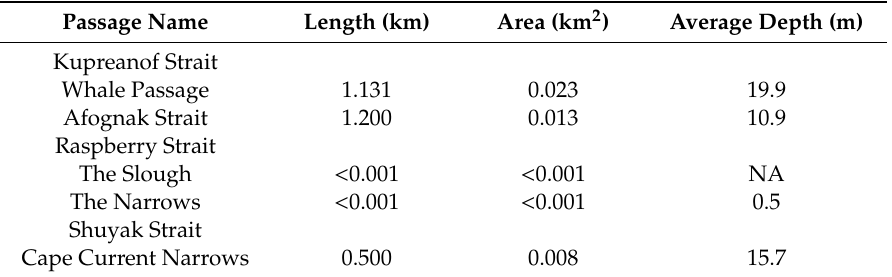
Table 3. Cross-sectional openings within the Kodiak Archipelago of the Gulf of Alaska.